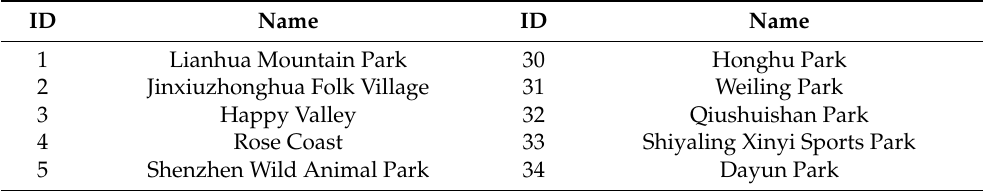
Table A1. List of selected parks in